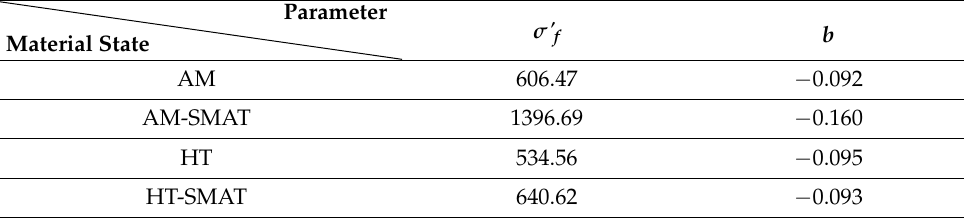
and b for different material states. f